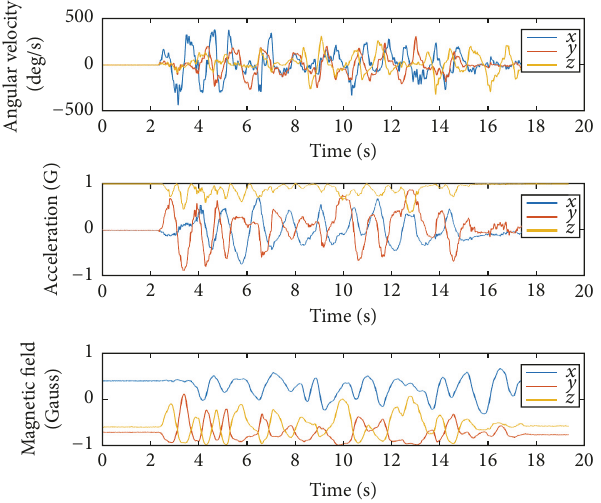
Figure 6: Inertial sensor data from miniature